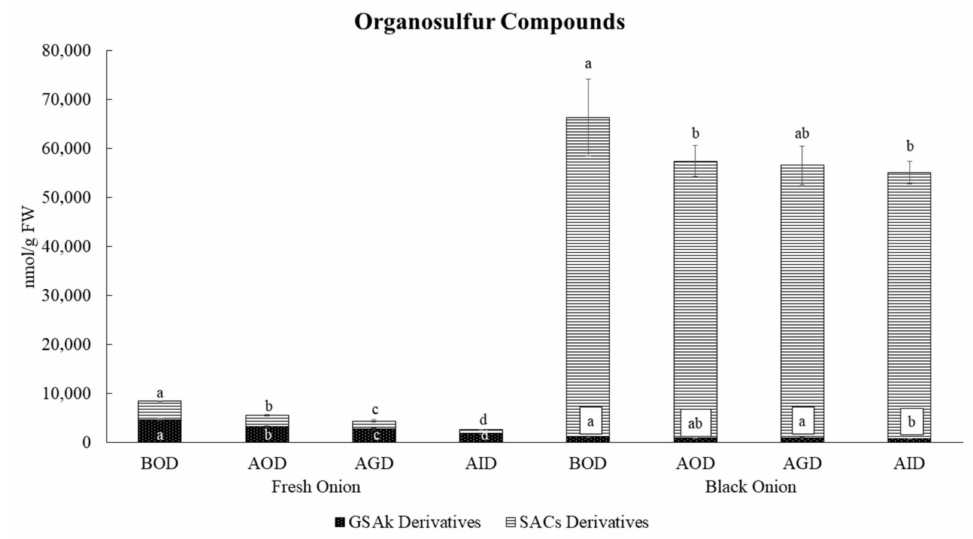
Figure 4. Quantities of organosulfur compounds during in-vitro simulated gastrointestinal digestion of fresh and black onion. Data are expressed in nmol/g FW as mean values ( n = 3). Different letters (one-way ANOVA) denote statistically significant differences between the stages of simulated gastrointestinal digestion ( p -value <